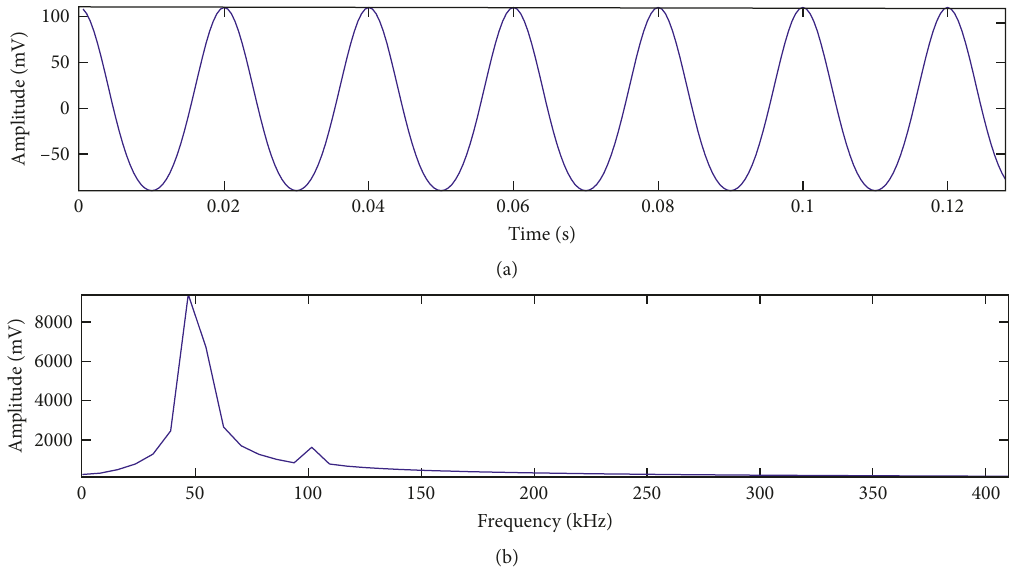
Figure 2: Time-frequency curve of the numerical signals.